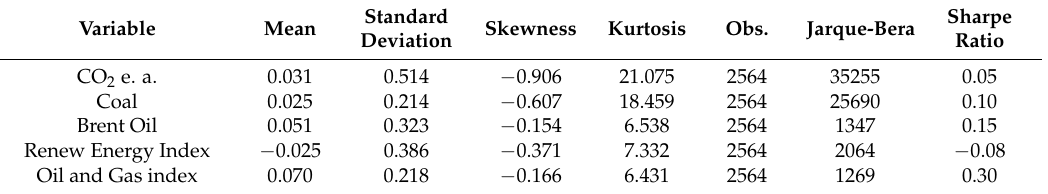
Table 2. Descriptive statistics for log returns on carbon dioxide emission allowances, coal, Brent oil, Stoxx 600 Europe renewable energy index with dividends, Stoxx600 Europe Oil and Gas index with dividends, 2 December 2008 to 28 September